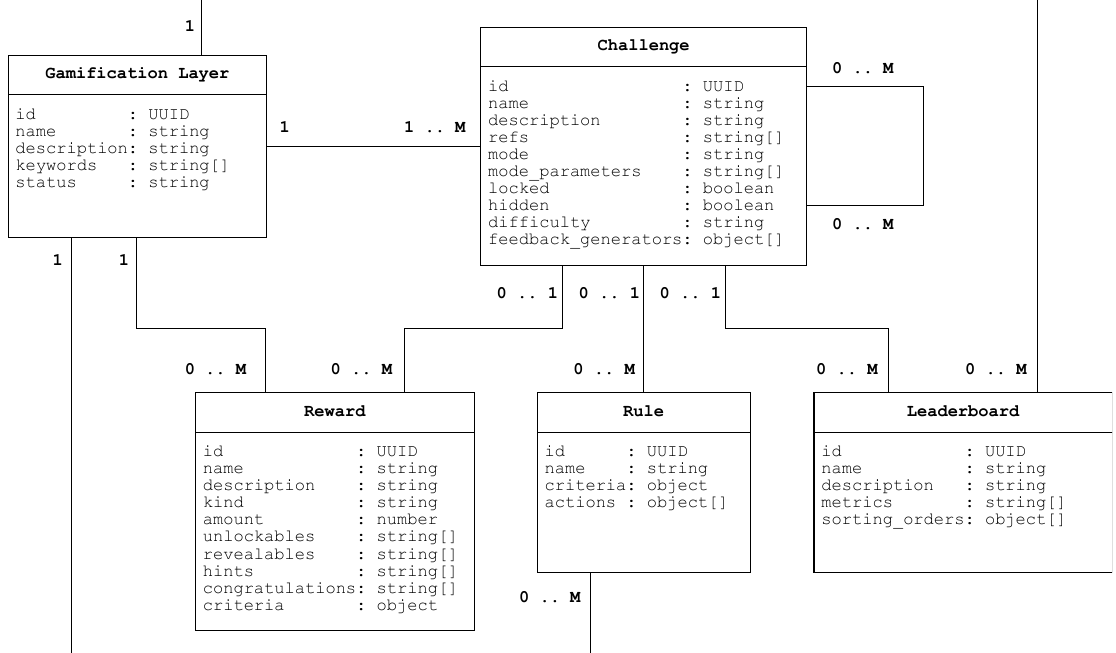
Figure 1. Data model defined by the GEdIL